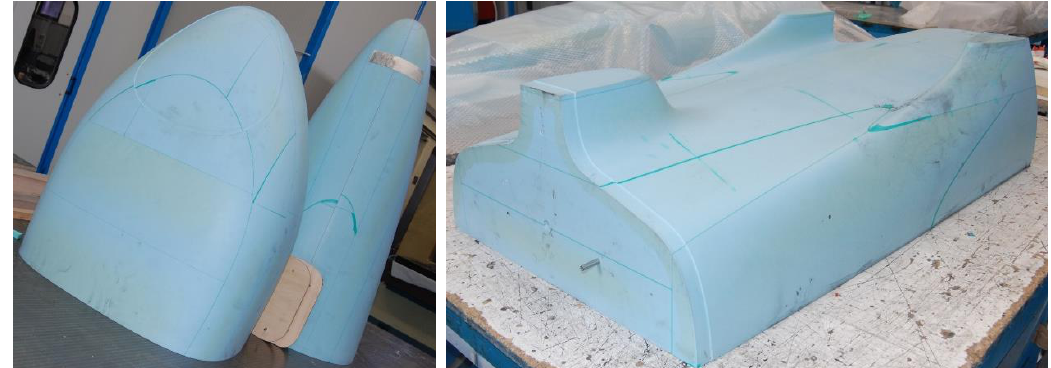
Figure 11. Male resin molds; front and rear end ( left ), and central part ( right ). Materials 2018 , 11 , x FOR PEER REVIEW